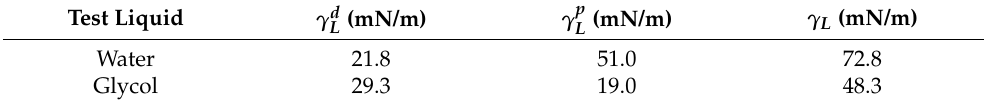
Table 5. The surface energy parameters of test liquids.